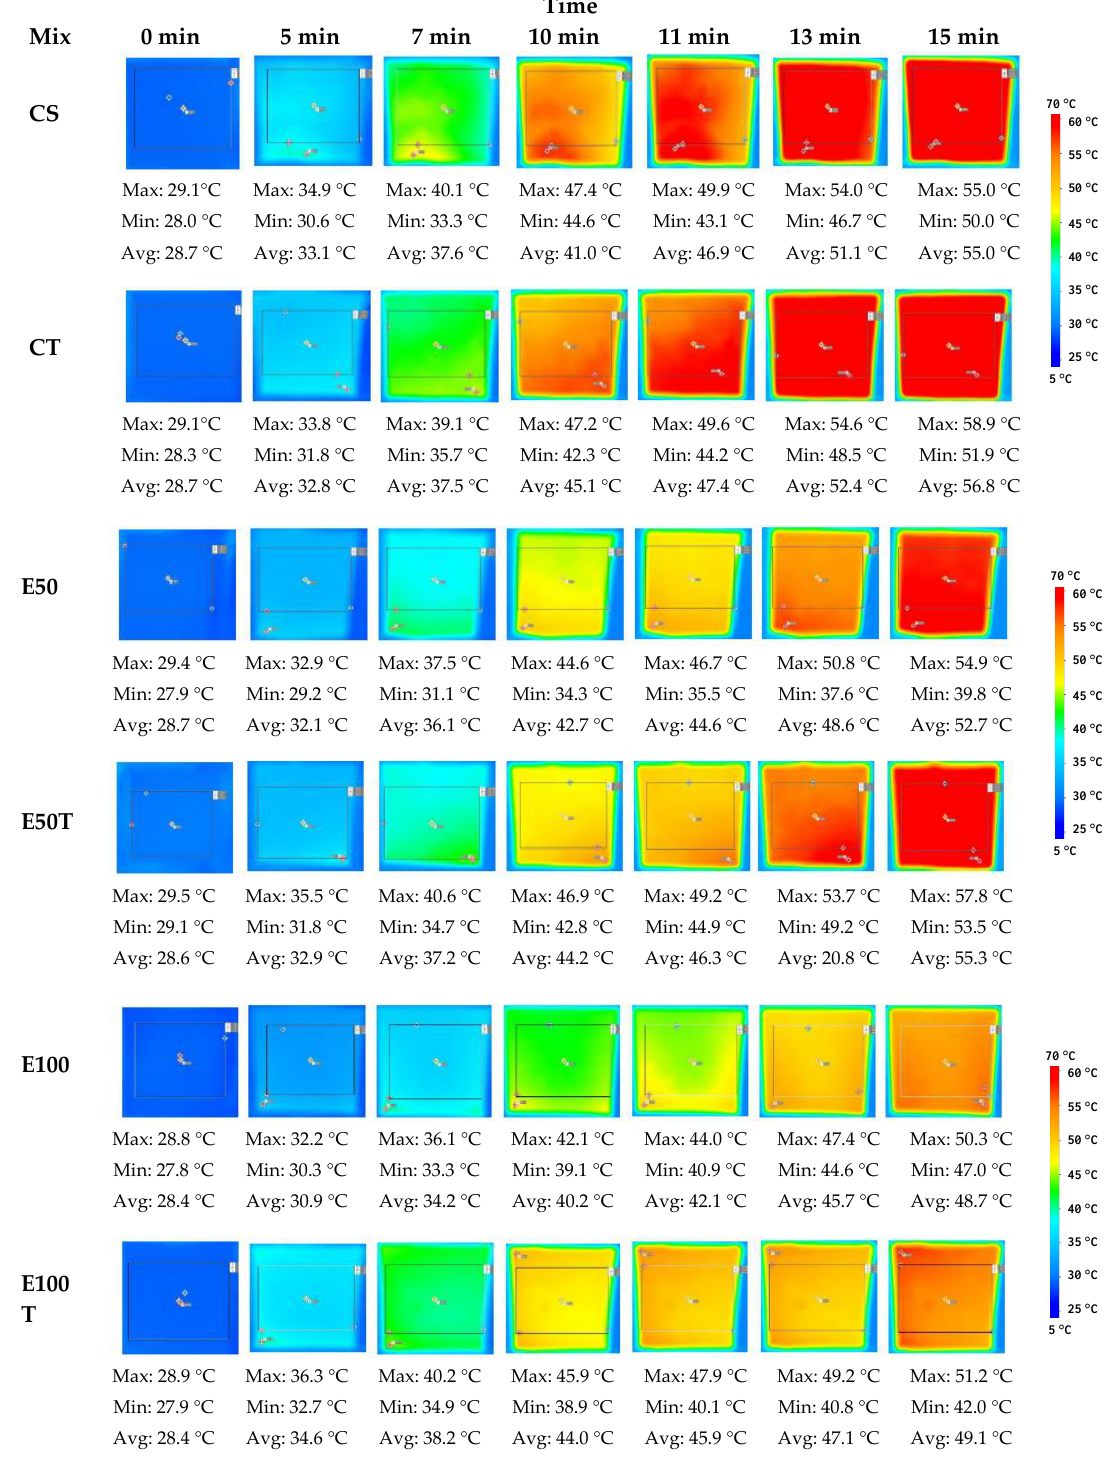
Figure 10. Infrared thermography images of different samples.